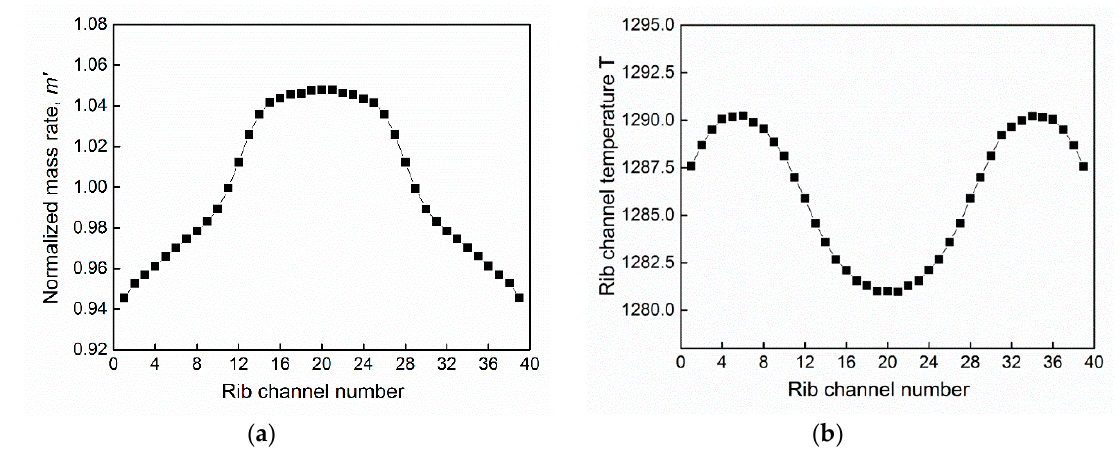
Figure 8. ( a ) The normalized air mass flow rate distributions obtained by the rib channels; ( b ) the temperature distributions across the channels.